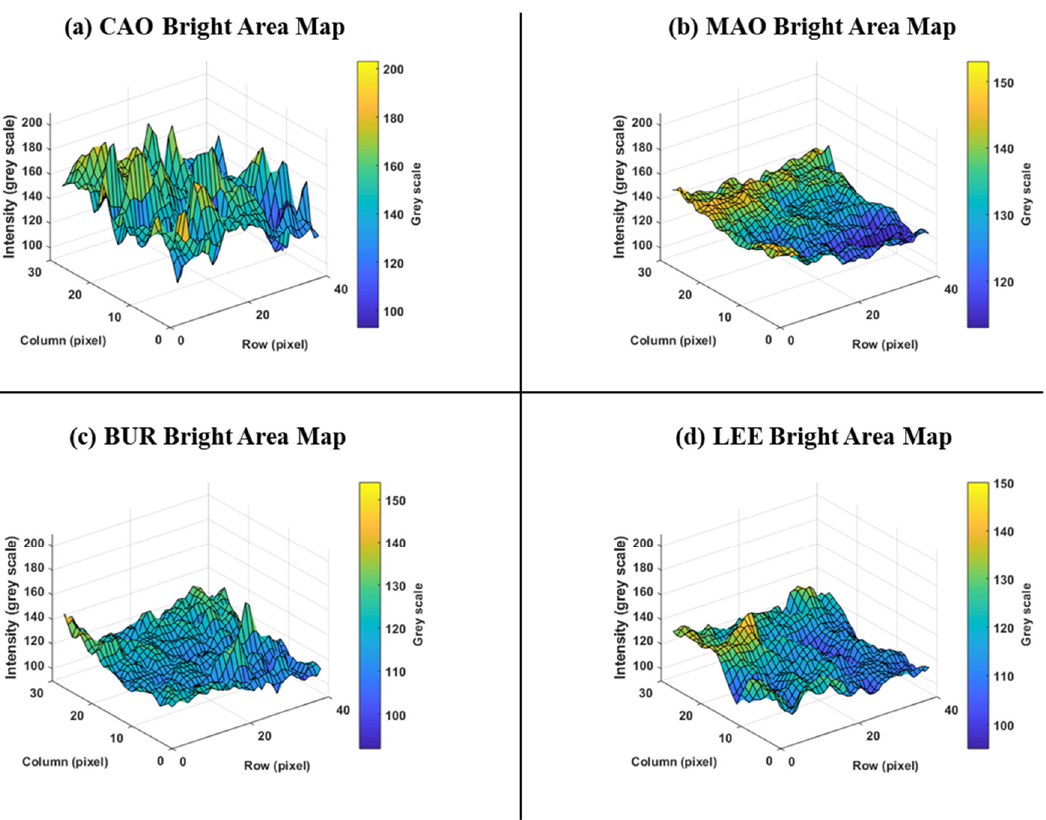
Figure 11. Surface intensity map of the bright area to be scanned on the optically reconstructed H3D object according to each encoding; ( a ) CAO encoding, ( b ) MAO encoding, ( c ) Burckhardt’s encoding (BUR), and ( d ) Lee’s encoding (LEE).